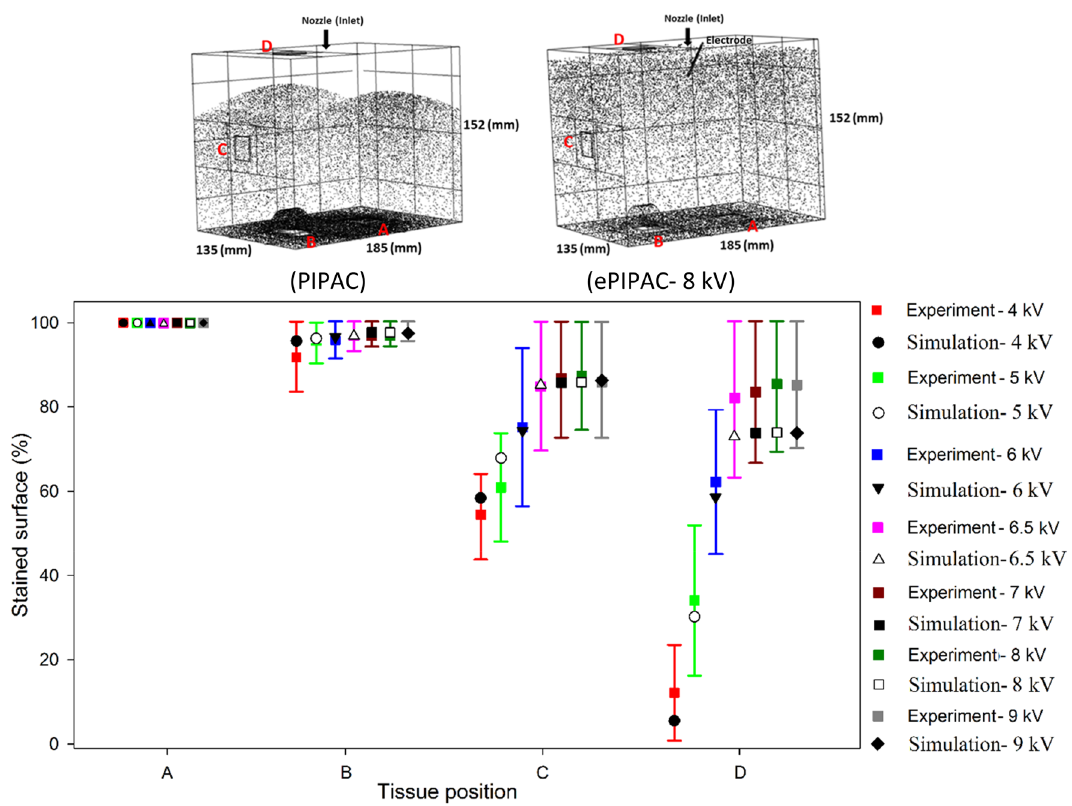
Figure 16. A comparison of the stained tissue surfaces (positions A–D) with black ink for different electrical potentials during ePIPAC between in vitro experiments and CFD simulations. Bars represent mean (± SD); experiments were repeated four